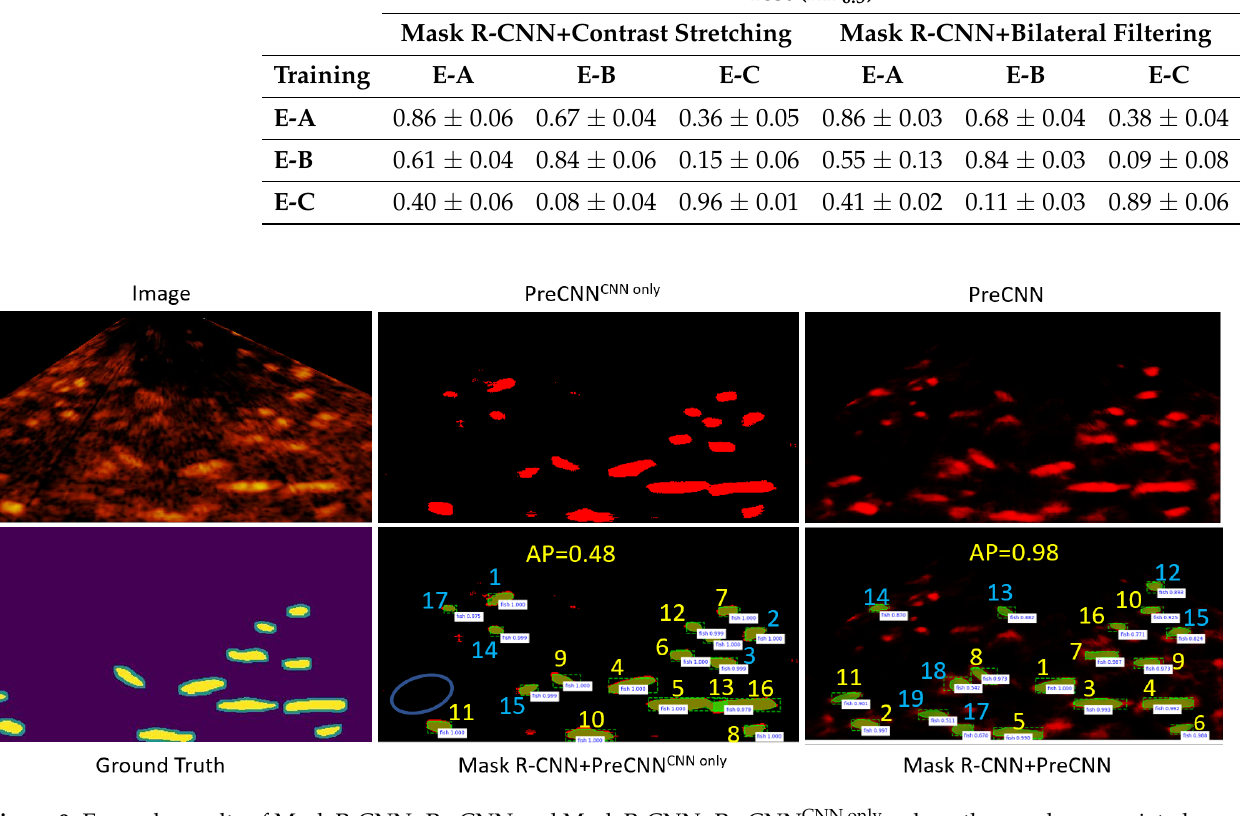
Figure 9. Example results of Mask R-CNN+PreCNN and Mask R-CNN+PreCNN CNN only , where the number associated with an object is the rank and the object with a blue number is not in the ground truth. Table 4. Experimental results of Mask R-CNN+PreCNN CNN only